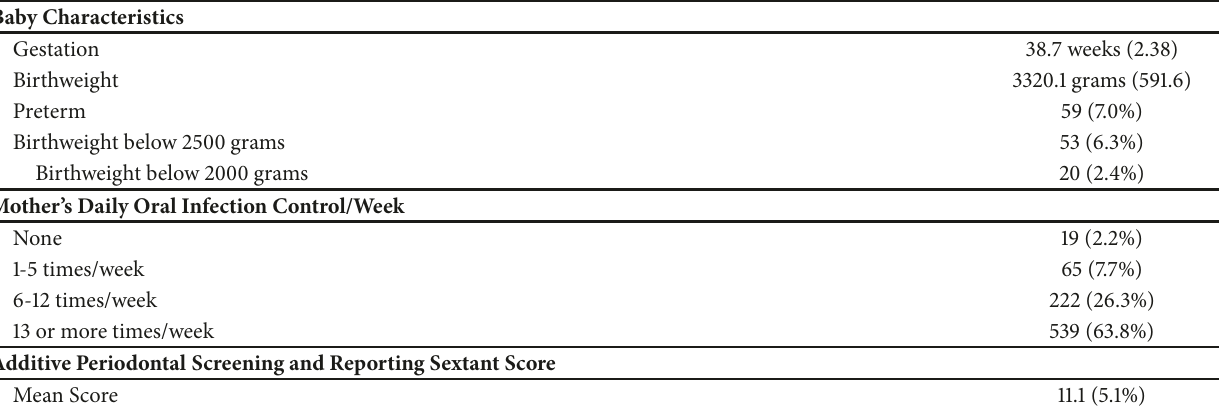
Table 1: Sample characteristics, N = 845. Mean (Standard Deviation) or frequency (%).